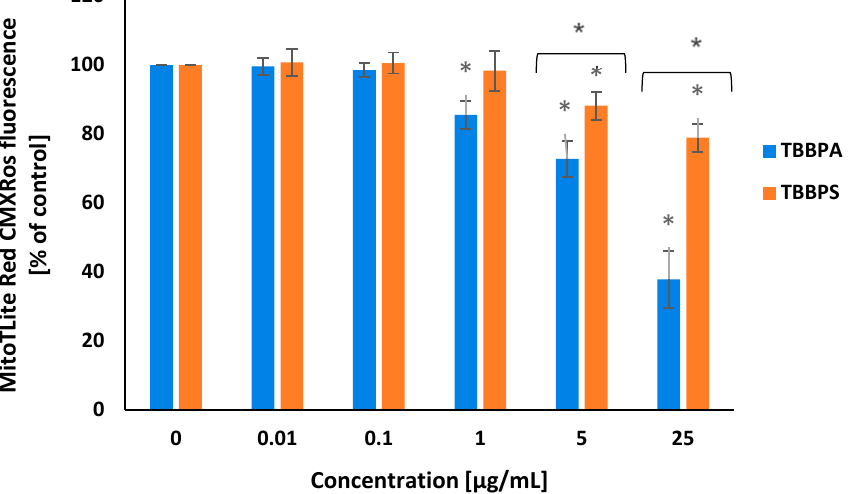
Figure 3. Alterations in transmembrane mitochondrial potential ( ∆Ψ m ) in PBMCs treated with TBBPA and TBBPS in the range from 0.01 to 25 µg/mL (n = 4) for 24 h. Statistically different from negative control at * p < 0.05. Statistical analysis was conducted using one-way ANOVA and a posteriori Tukey test.